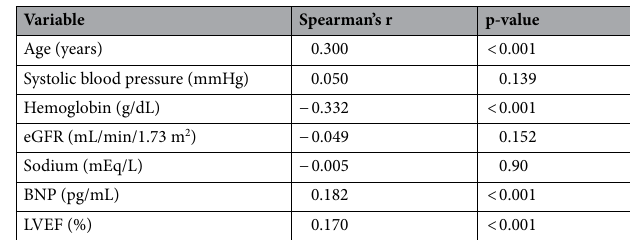
Table 2. Univariate correlations between the GPS and baseline indices. Correlations between GPS and clinical and laboratory indices were evaluated by Spearman’s rank test. BNP B-type natriuretic peptide, eGFR estimated glomerular filtration rate, GPS Glasgow Prognostic Score, LVEF left ventricular ejection fraction.